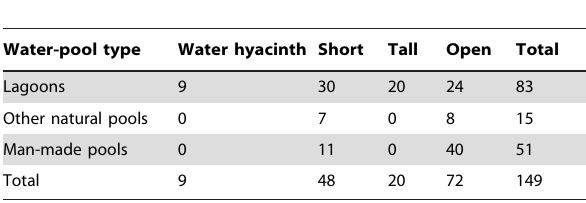
Table 3. Numbers of microhabitats sampled in the three types of water pools that were adjacent to the